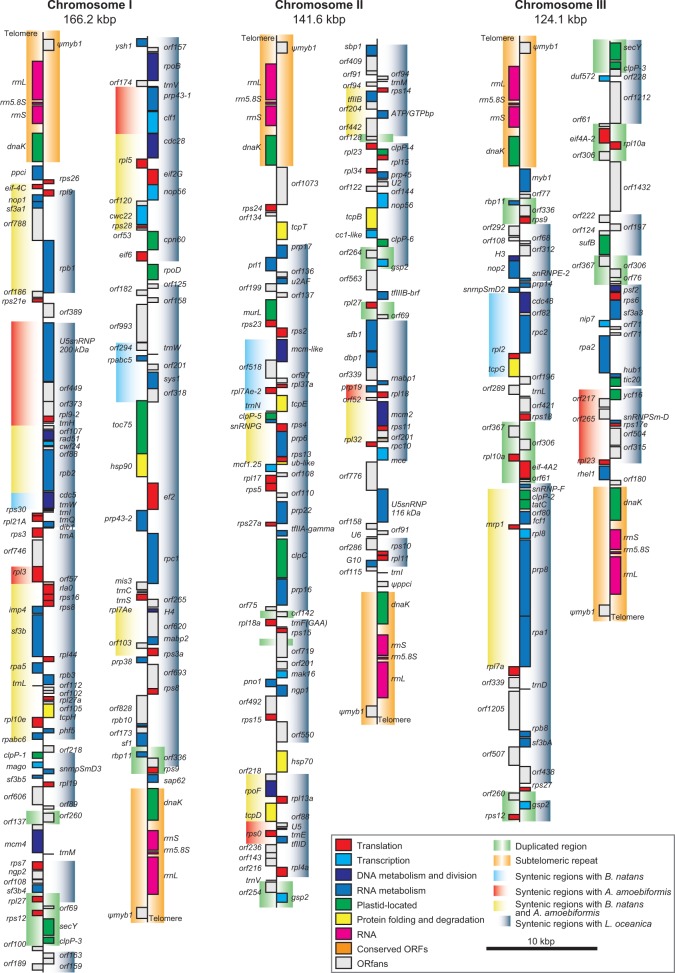
Nucleomorph genome map of the chlorarachniophyte L. vacuolata. The genome is comprised three chromosomes, which are shown artificially broken at their midpoint. Genes indicated on the right side are transcribed from top to bottom, and the genes on the left side are transcribed in the opposite direction. Colors of gene blocks correspond to predicted functional categories in the box. Duplicated gene regions (green) and syntenic regions with B. natans (blue), A. amoebiformis (red), L. oceanica (gray), and both B. natans and A. amoebiformis (yellow) are shaded by color gradations.